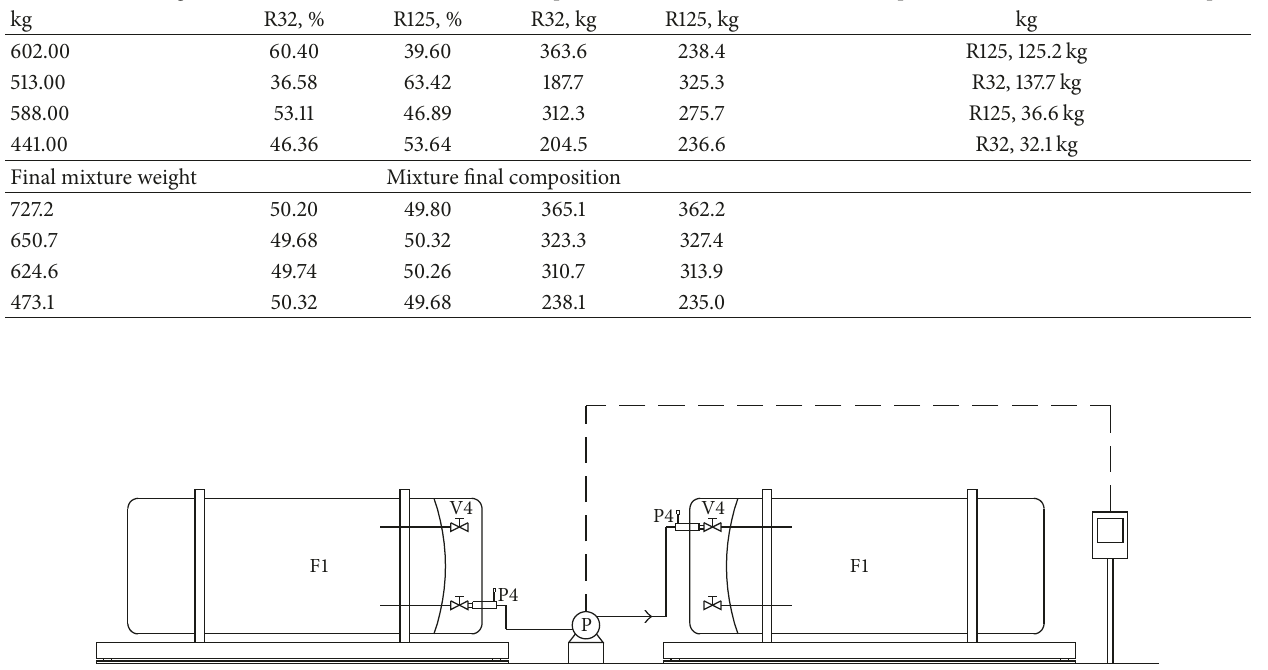
Figure 6: Scheme of the equipment to maintain the refrigerant mixture